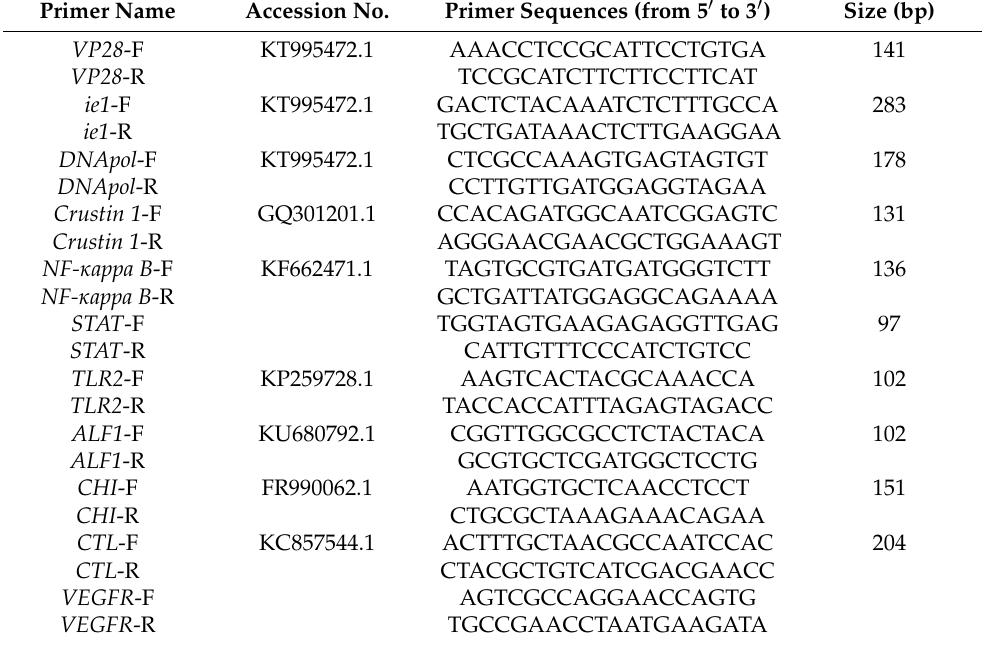
Table 1. Primers used in this